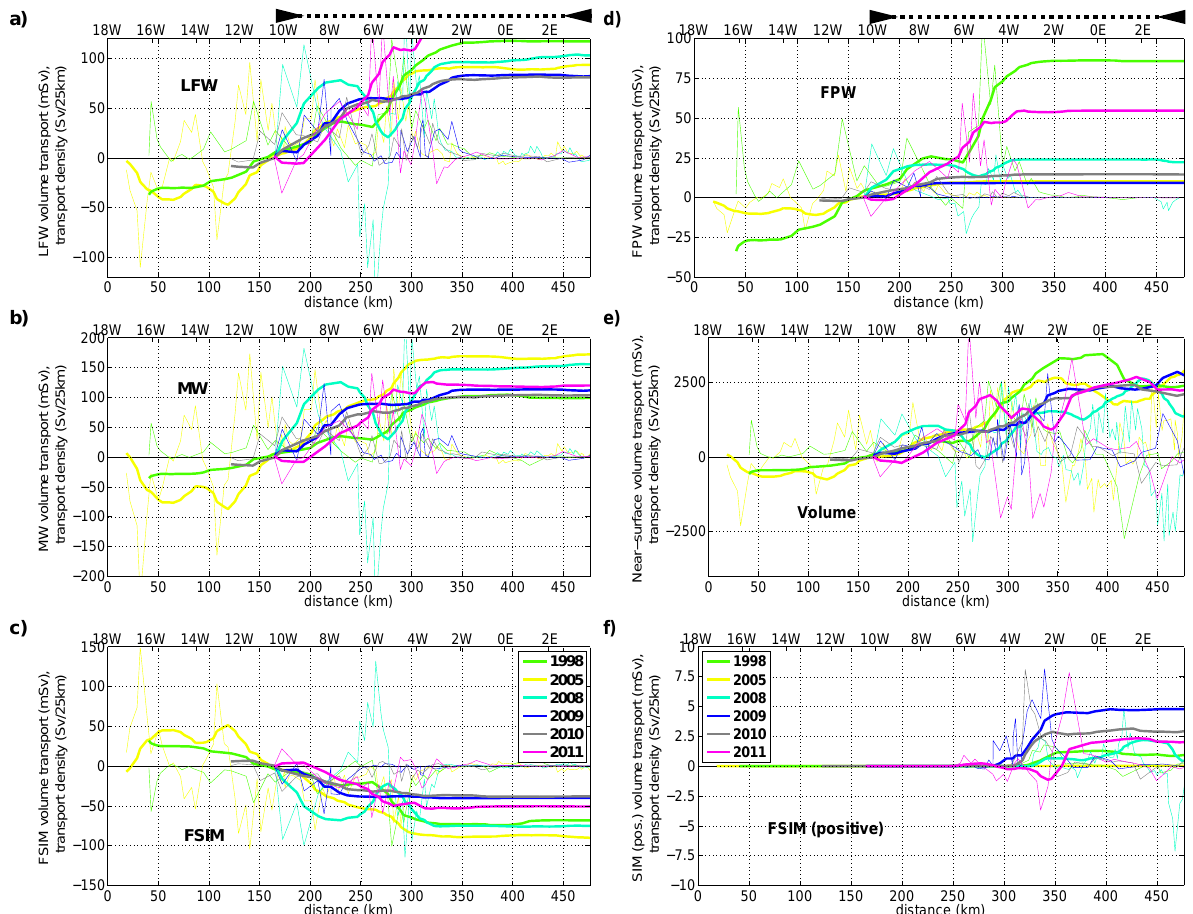
Fig. 4. Meridional transports of LFW components along the Western Fram Strait: (a) LFW, (b) MW, (c) FSIM, (d) FPW. The volume transport in the upper 300m is shown in (e) . Transport density is shown as thin lines and transports cumulated from 10.6 ◦ W as thick lines. Transports are positive southward. Results from different years are marked in colour, according to the legend in (e) . Largely negative FSIM transports largely represent a southward transport of negative fractions of FSIM, dominated by sea ice brine, and not a northward transport of positive FSIM fractions. This is evident in the magnitude of transports of only positive fractions of FSIM in (f) . The part of the section used for the “section” transports in Fig. 5 is marked by the thick dashed lines in (a) and (d) .